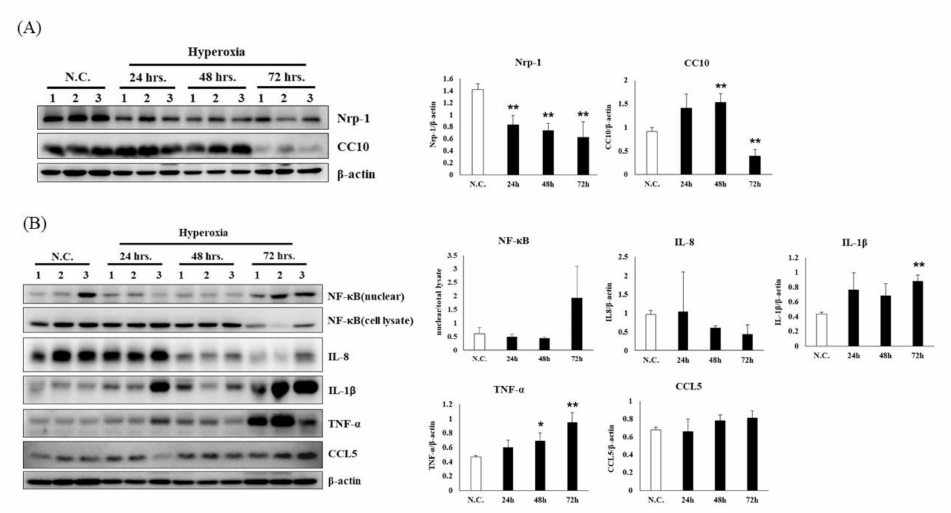
Figure 2. Changes in the protein expression levels for ( A ) alveolar injury and ( B ) inflammation of lung tissues in NF- κ B–luciferase transgenic mice after induction of hyperoxia for 0, 24, 48 and 72 h. The reported values are expressed as the mean ± SEM ( n = 6). Values assigned to letters (*, **) are significantly di ff erent at p < 0.05 and are determined using Duncan’s multiple range